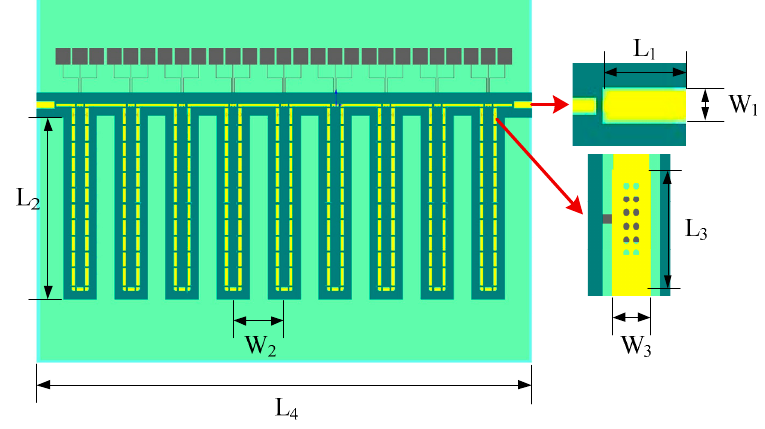
Figure 5. MEMS TTDL network diagram.